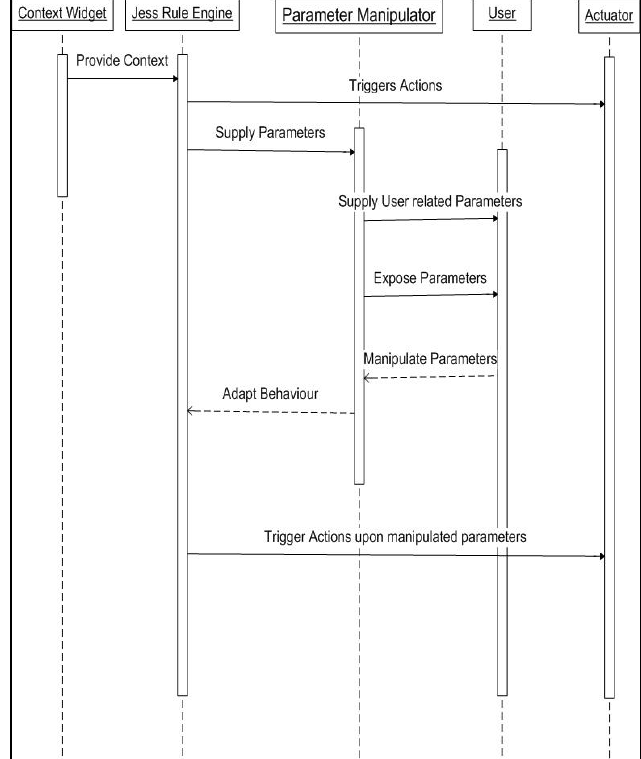
Figure 4. Sequence Diagram for the Parameters